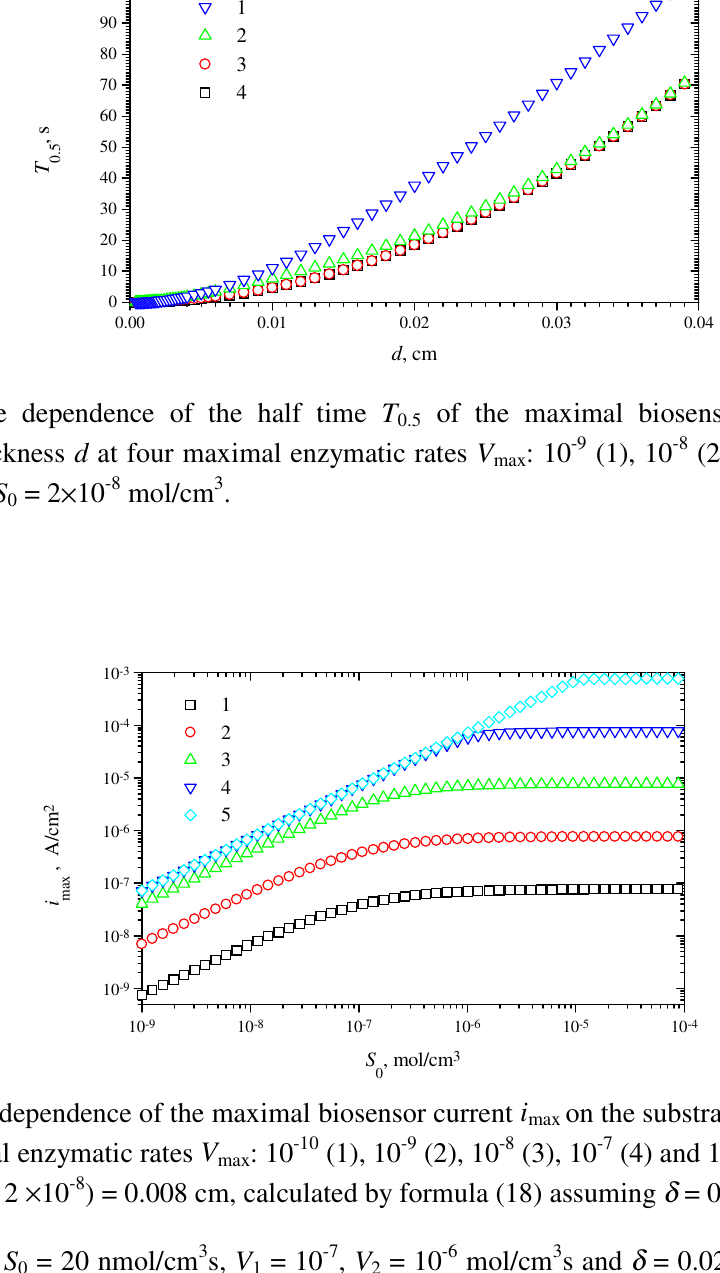
Figure 4 . The dependence of the maximal biosensor current i max on the substrate concentration S 0 at five maximal enzymatic rates V : 10 -10 (1), 10 -9 (2), 10 -8 (3), 10 -7 (4) and 10 -6 (5) mol/cm 3 s, d max = d (10 -7 , 10 -6 , 2 · 10 -8 ) = 0.008 cm, calculated by formula (18) assuming d = d